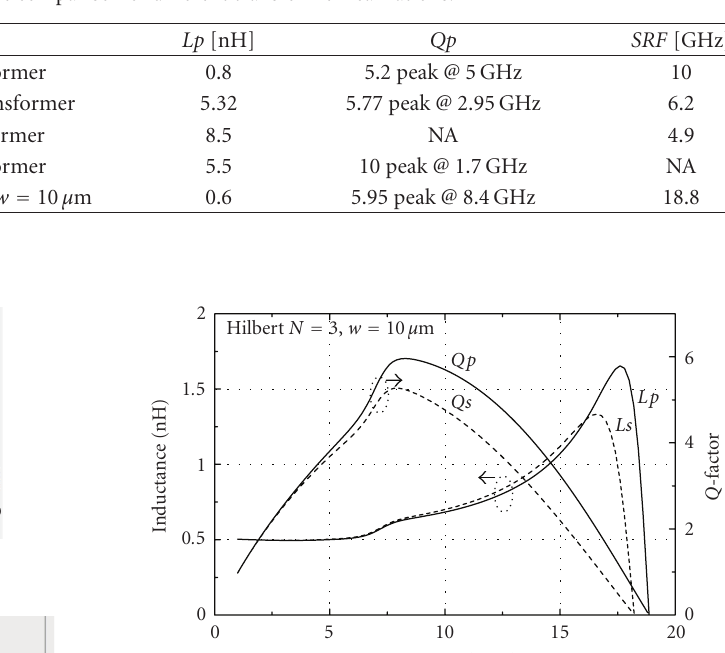
Table 1: The performance comparison of di ff erent transformer realizations.